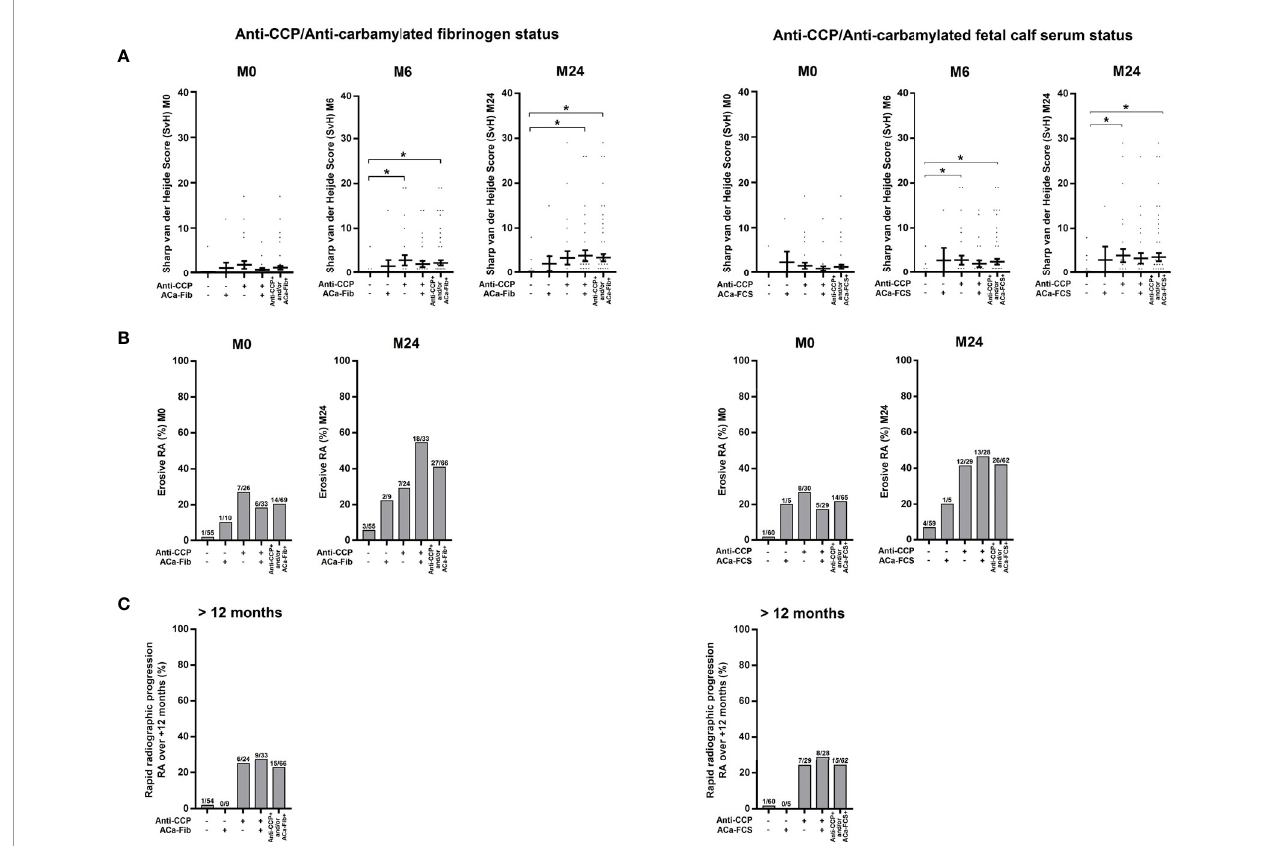
FIGURE 7 | Evolution of structural parameters of RA patients according to anti-CCP antibodies and ACa-Fib or ACa-FCS status. (A) van der Heijde modi fi ed Sharp score at baseline (M0), 6 months (M6), and 2 years (M24) according to Anti-CCP/ACa-Fib status or Anti-CCP/ACa-FCS status. Averages with SEM are shown. Groups were compared using one-way ANOVA and Tukey post-test, *p-value<0.05. (B) Percentage of erosive RA at baseline (M0) and 2 years (M24) according to Anti-CCP/ACa-Fib status or Anti-CCP/ACa-FCS status. (C) Percentage of patients with rapid radiographic progression over a period of 12 months starting from M0 according to Anti-CCP/ACa-Fib status or Anti-CCP/ACa-FCS status. Anti-CCP, anti-cyclic citrullinated peptide antibodies; ACa-Fib, anti-carbamylated fi brinogen antibodies; ACa-FCS, anti-carbamylated fetal calf serum